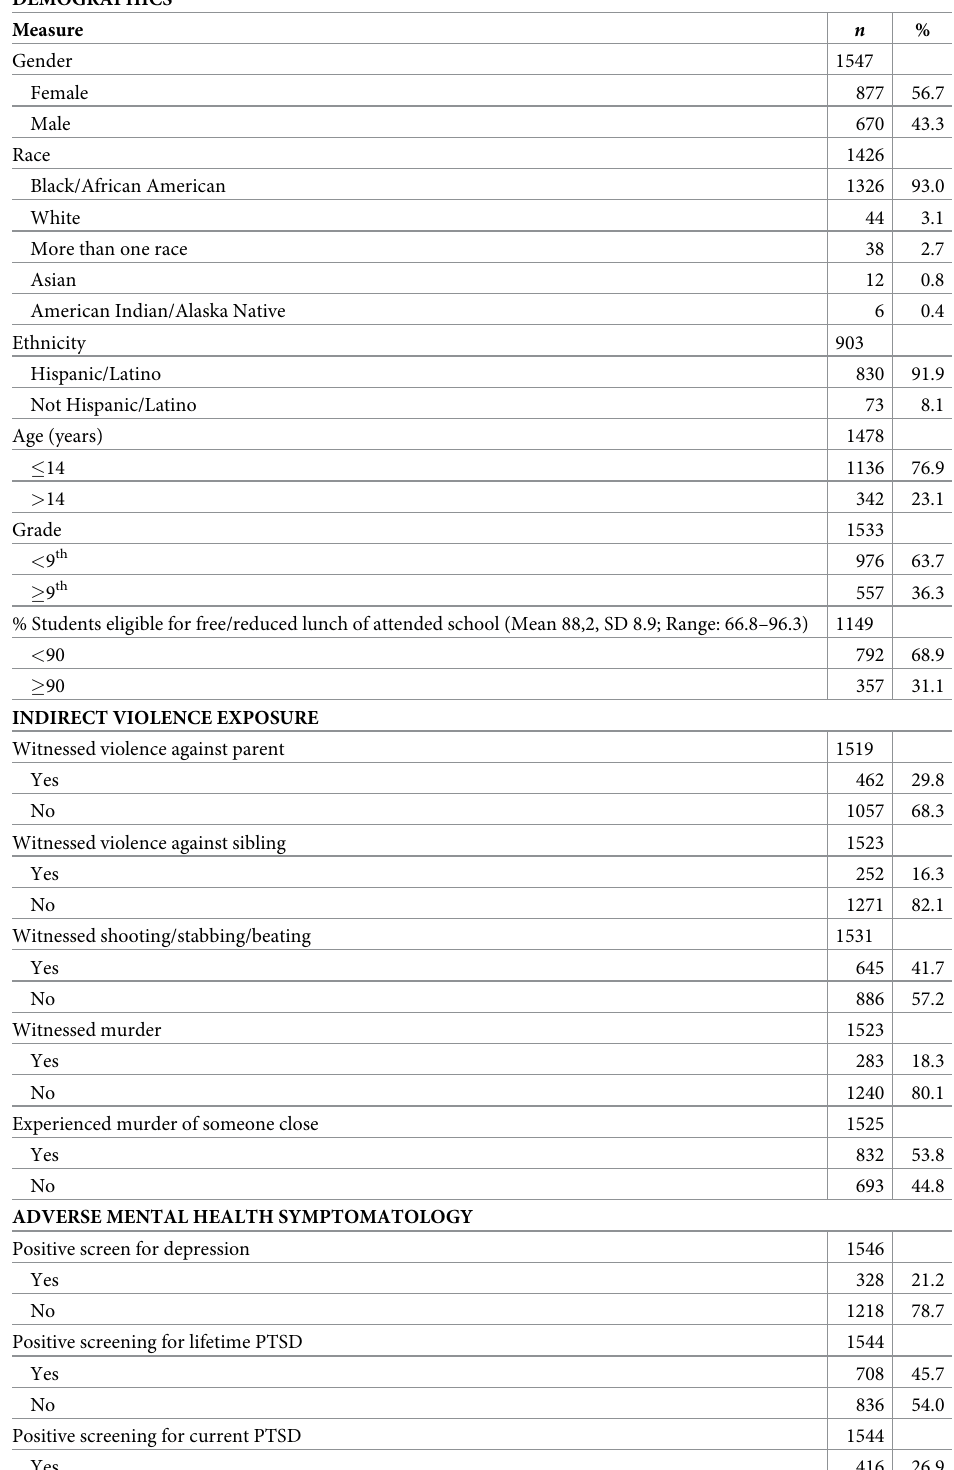
Table 1. Descriptive statistics of IWES believe in youth–louisiana (BY-LA) participants (N =